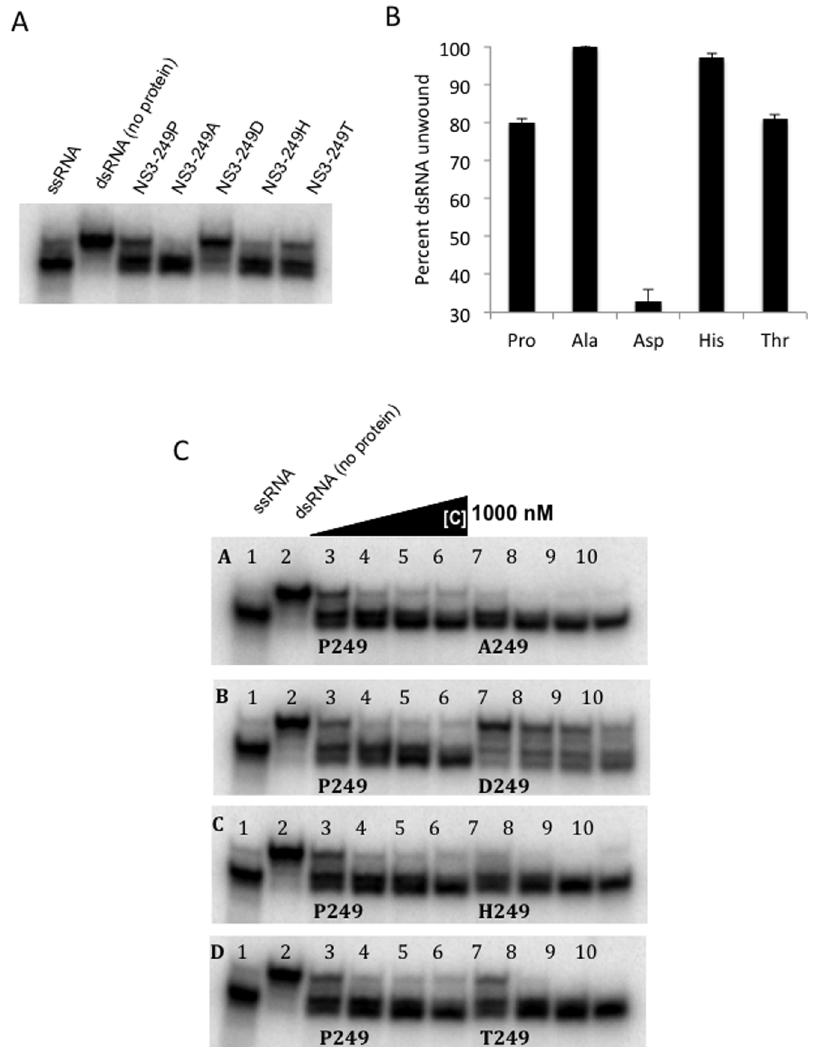
Figure 8. Helicase activity of recombinant WNV helicase NS3-249 protein mutants. (A) Helicase activity with fixed concentration of NS3 (125 nM). Lane 1: ssRNA (heat denature dsRNA), Lane 2: dsRNA (no protein), Lane 3: NS3-249P, Lane 4: NS3-249A, Lane 5: NS3-249D, Lane 6: NS3- 249H, Lane 7: NS3-249T. (B) Percent dsRNA unwound by each NS3-249 helicase point mutants at 125 nM. (C) Helicase activity with increasing concentrations of NS3 (125 nM, 250 nM, 500 nM and 1,000 nM).